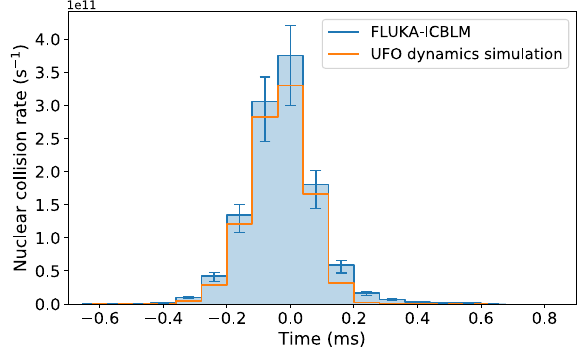
FIG. 15. Comparison between the measured beam losses by the local ICBLM and the simulated losses showing the best agree- ment. The total number of inelastic collisions was 5 . 2 × 10 7